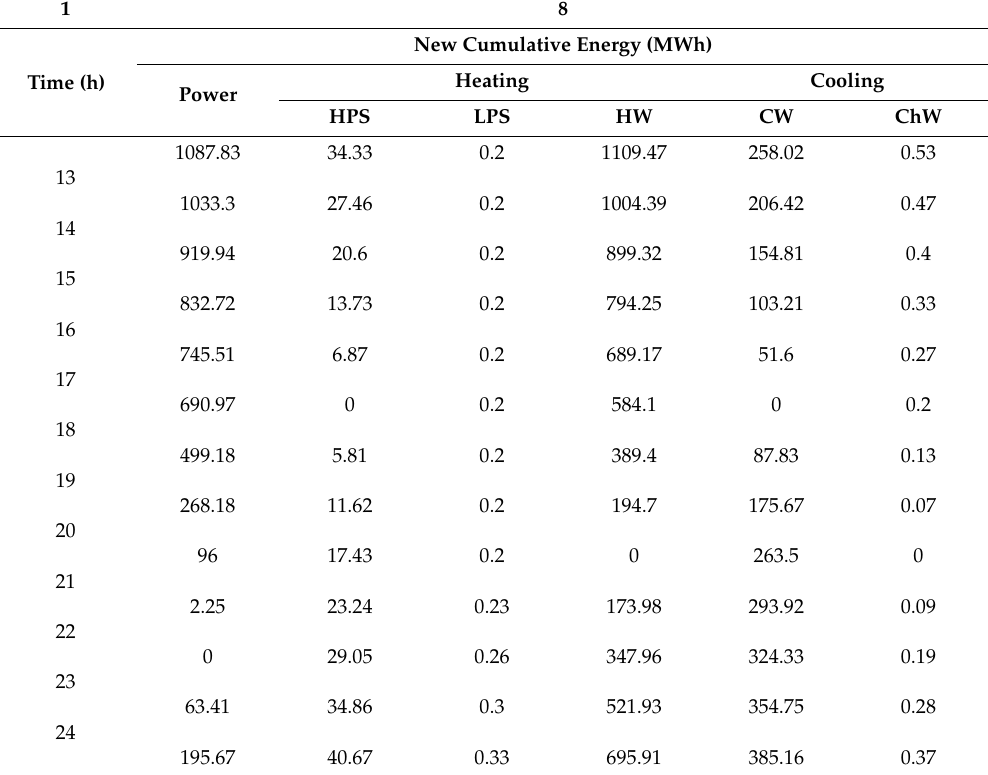
Table A26. TriGenSCA for final trigeneration PWR NPP without integration from 13 to 24 h.